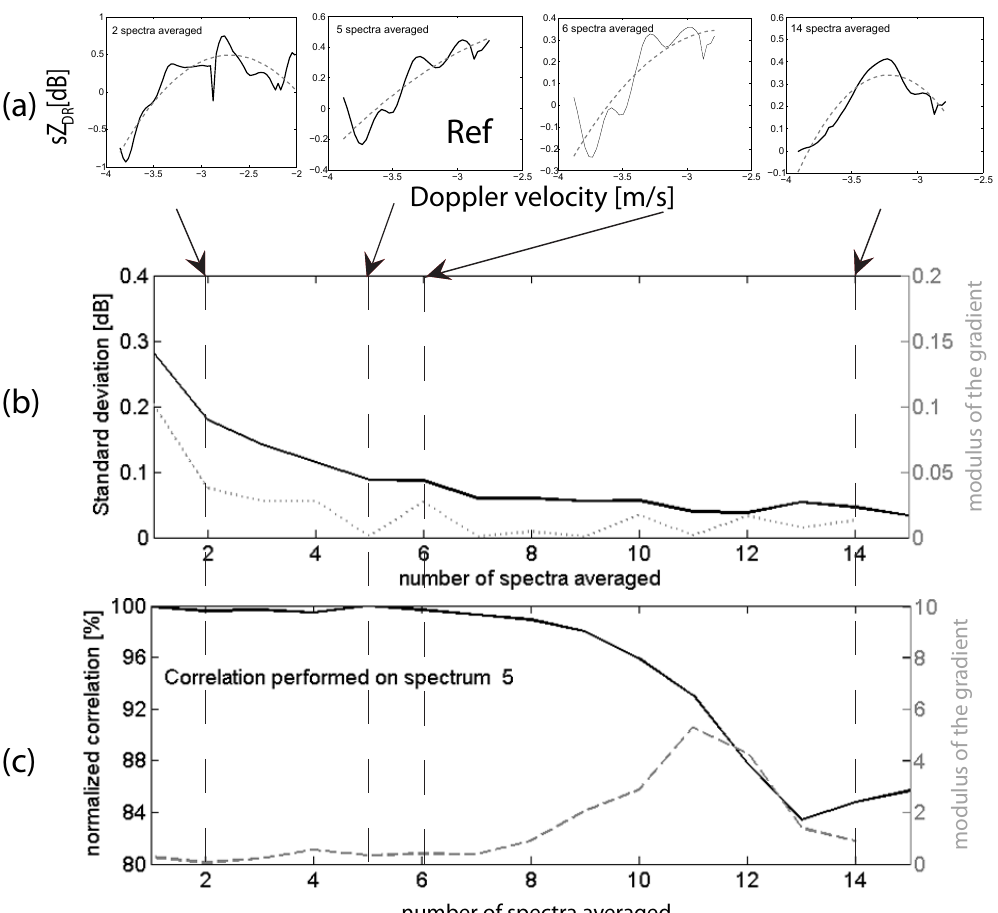
Fig. 5. Example of statistical analysis performed with sZ DR parabolic fit on 15 consecutive spectra for a specific initial time and range bin of a TARA measurement. (a) Representation of the sZ DR spectra obtained with their parabolic fit for different numbers of spectra averaged (i.e. different averaging times). (b) Evolution of the standard deviation coefficient and the modulus of its gradient with the number of spectra averaged. (c) Evolution of the correlation coefficient R d for N av , min = 5 (average on 5 spectra), where std is found below